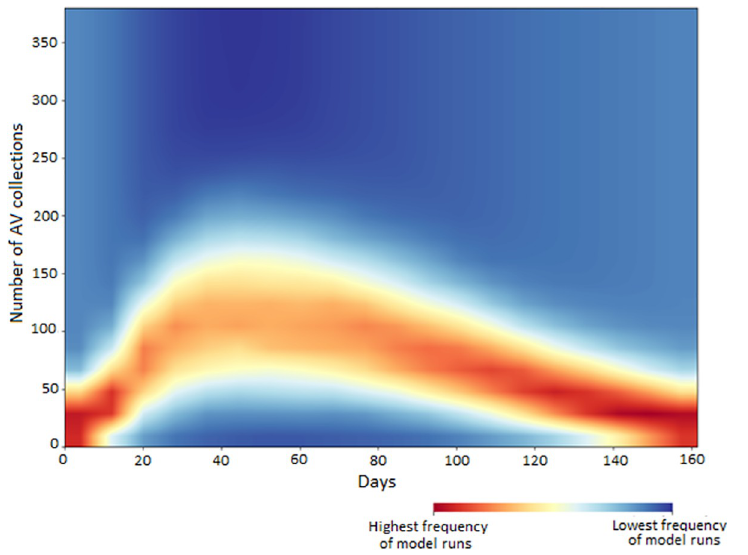
Fig 2. A 2D histogram showing output from a 5,000 iteration Monte Carlo uncertainty analysis.